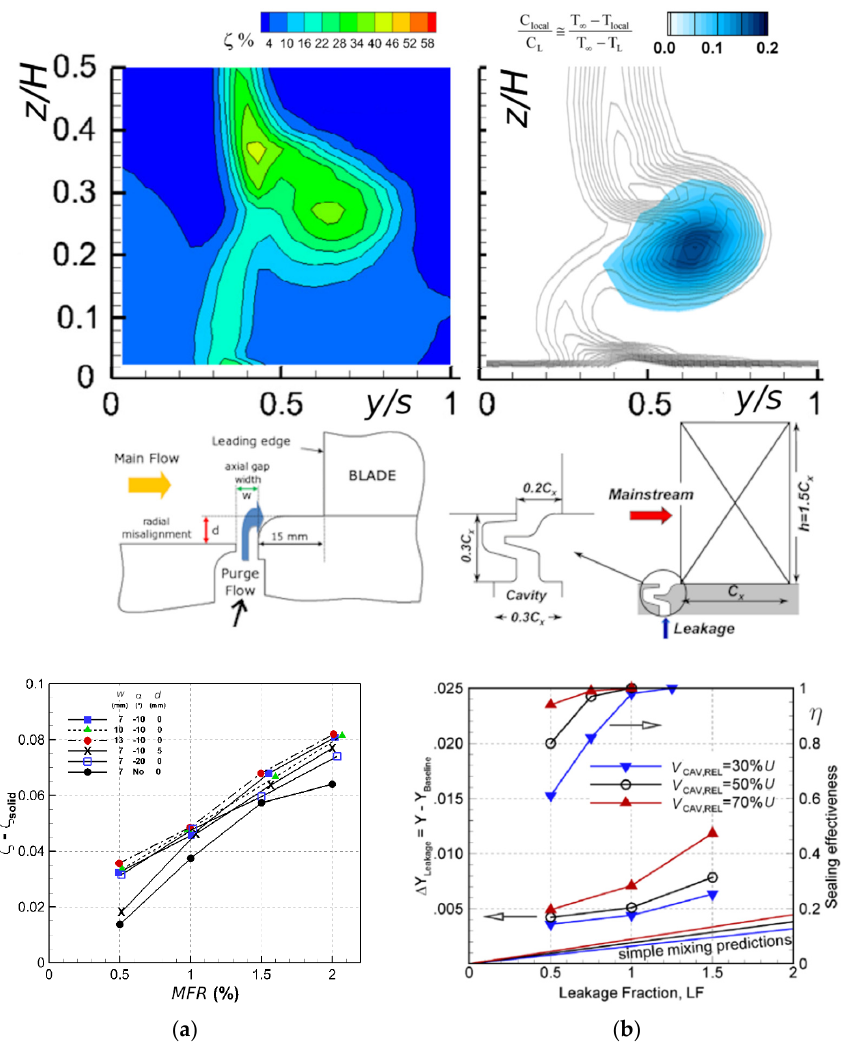
Figure 6. Overall losses due to leakage: ( a ) Local kinetic energy loss distribution measured at x/C ax = 108% and MFR = 1% ( top ), platform configuration ( mid ) and mixed-out loss coefficient ( bottom ) by [22] and ( b ) total pressure loss coefficient lines superimposed over flood contours measured at x/C ax = 150% for leakage concentration of 1% ( top ), rim seal configuration ( mid ) and aerodynamic losses and sealing effectiveness ( bottom ) by